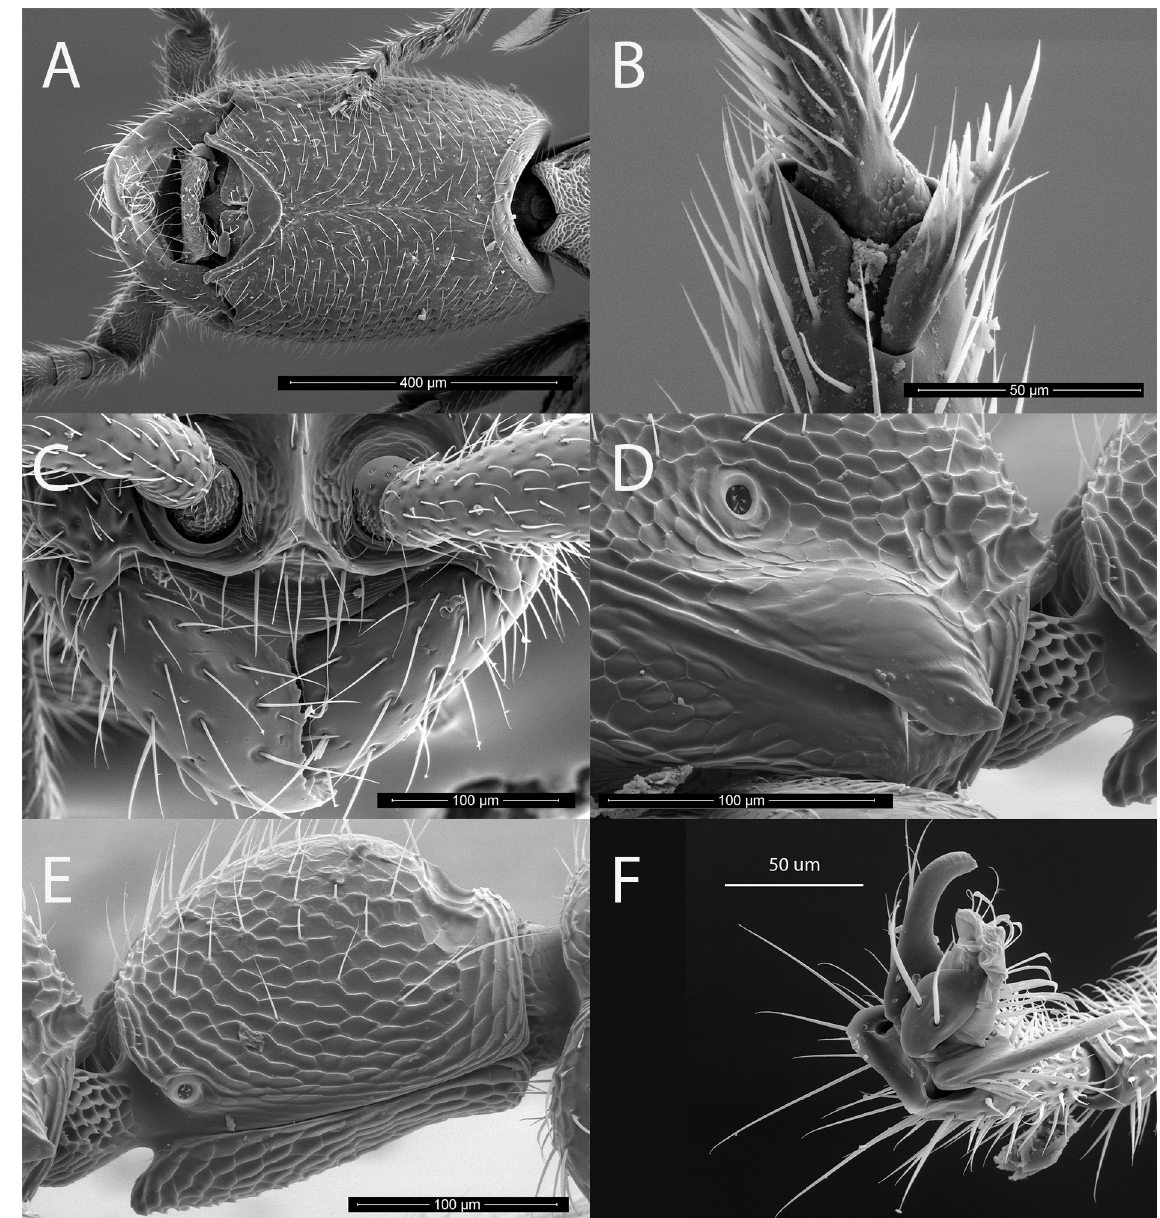
Fig. 6. Leptanilloides prometea Delsinne & Donoso sp. nov. Paratype worker (specimen code 4052301). A . Head, ventral view. B . Mesotibial pectinate spur. C . Anterior part of the head in full-face view, showing vertical and fused frontal carinae, exposed antennal socket, well-developed lateroclypeal tooth, strongly convex clypeal lamella and subtriangular mandible with minute denticles along its inner margin. D . Lower part of propodeum in lateral view, showing the flange over the metapleural gland opening. E . Petiole in lateral view. F . Simple claw